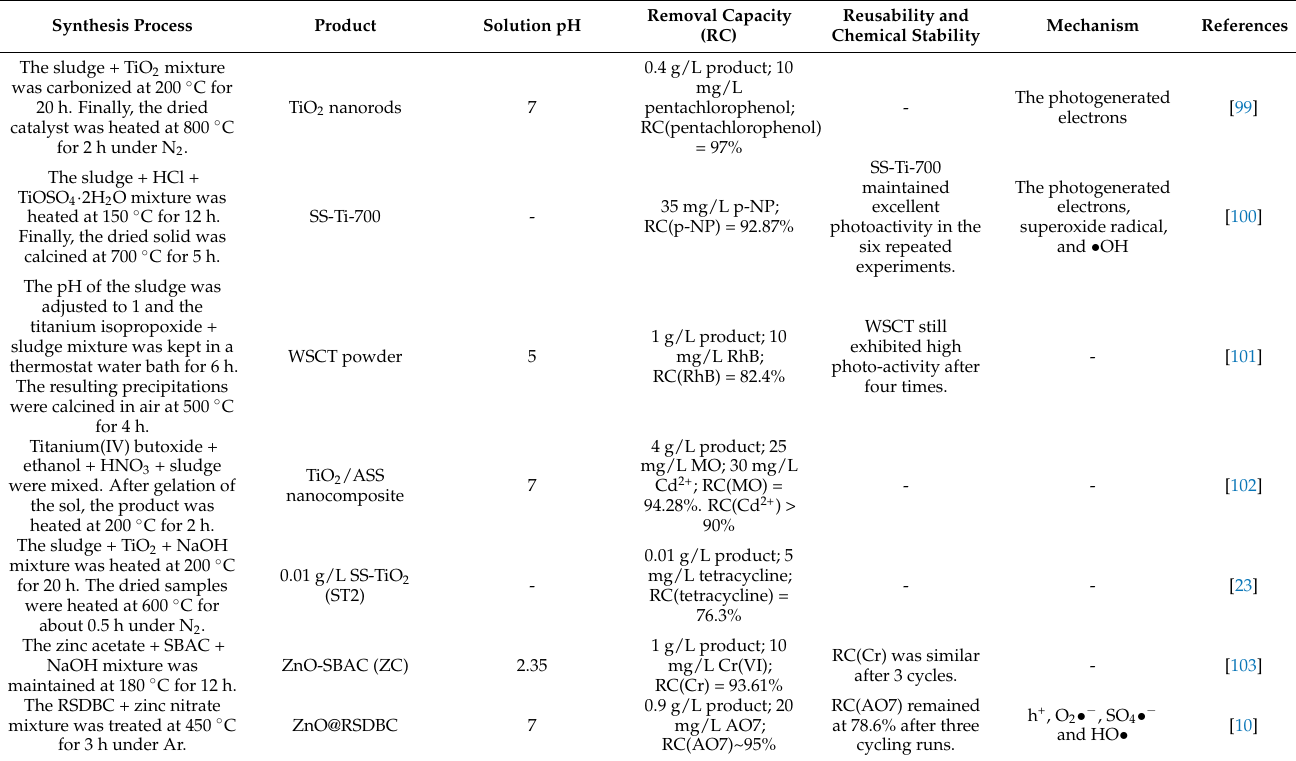
Table 4. Application of sludge-based catalysts in